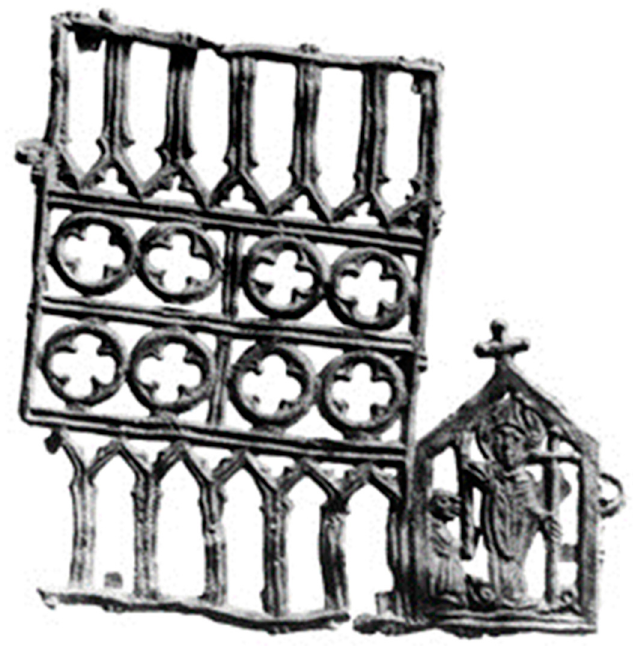
Figure 11. Pilgrim souvenir in the shape of a foldable reliquary, 14th / 15th century. Praha, Museum of Decorative Arts, Prague, Czech Republic. Photo: After Kühne, Jungfrauen, Engel, Phallustiere, p. 150, cat. 266.